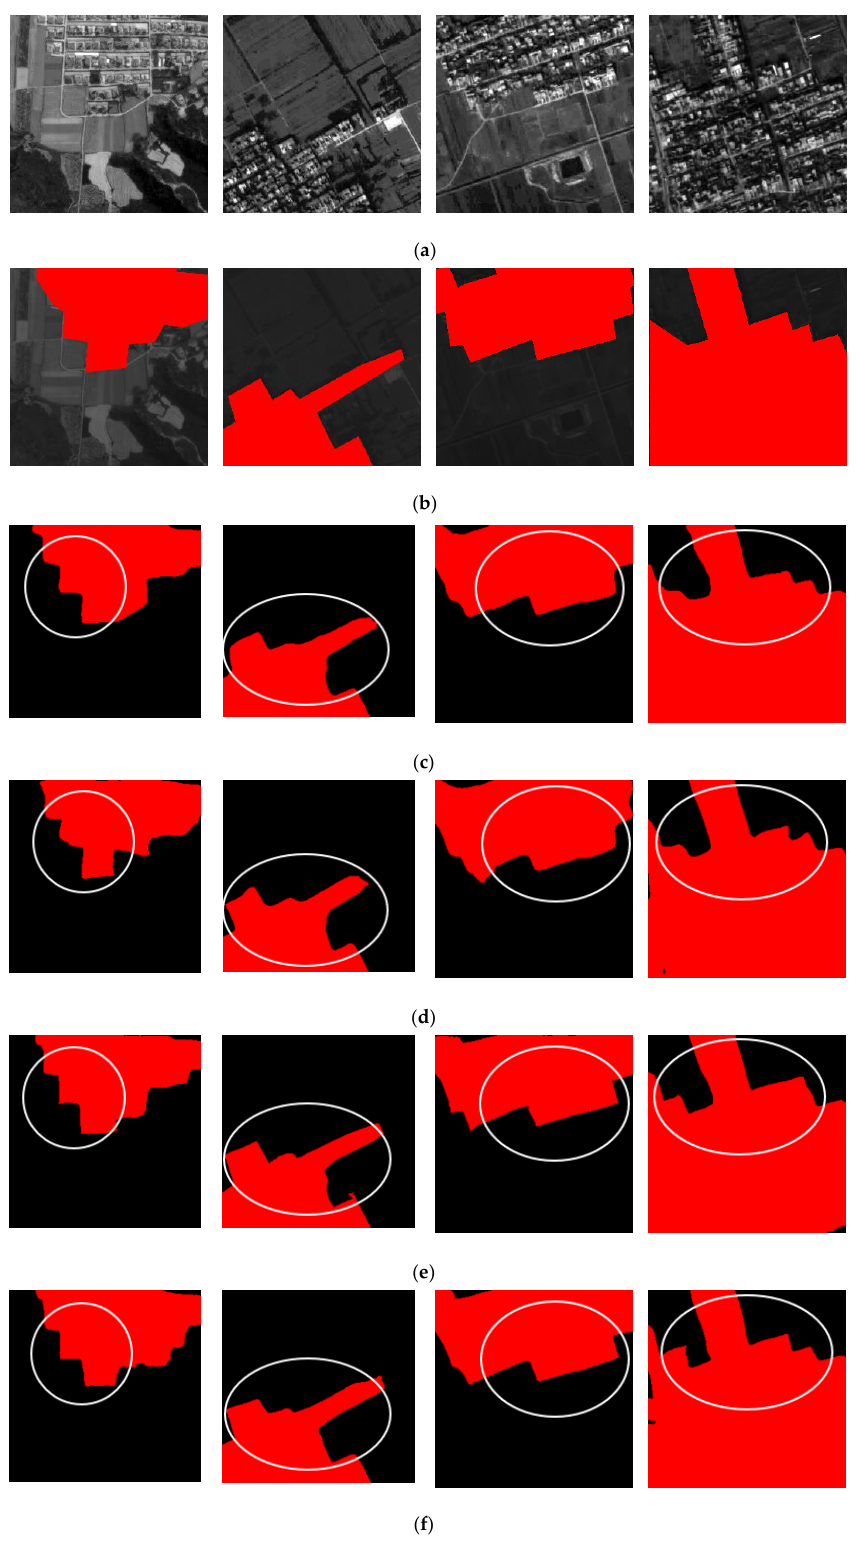
Figure 9. Extraction results of some residential areas: ( a ) Original images; ( b ) label images; ( c ) U- Net; ( d ) DeepLab v3+; ( e ) our model (the baseline network is U-Net); and ( f ) our model (the baseline network is DeepLab v3+).